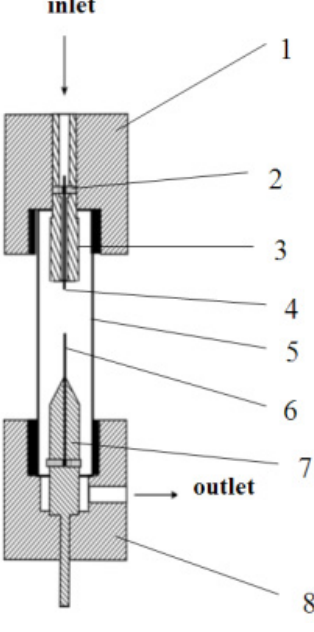
Figure 2 : Schema of the spark reactor: 1,8 - plastic covers, 2 - bolts, 3,7- stainless steel fence, 4,6 - electrode rods, 5 - quartz